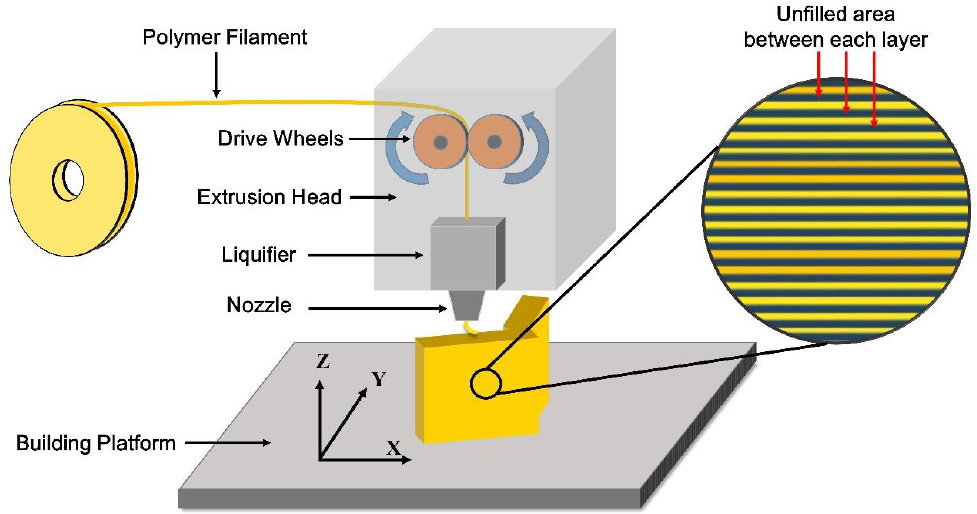
Figure 11. The working principle of the FDM technique. During the layered manufacturing process of FDM, the unfilled area can be found between each deposited layer, resulting in the original roughness on the FDM-printed